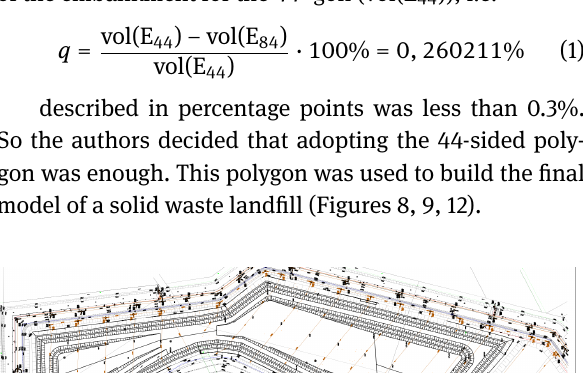
of the difference of the volume of the embankment for the 44–gon (vol(E 44 )) and 84–gon (vol(E 84 )) and the volume of the embankment for the 44–gon (vol(E 44 )), i.e.